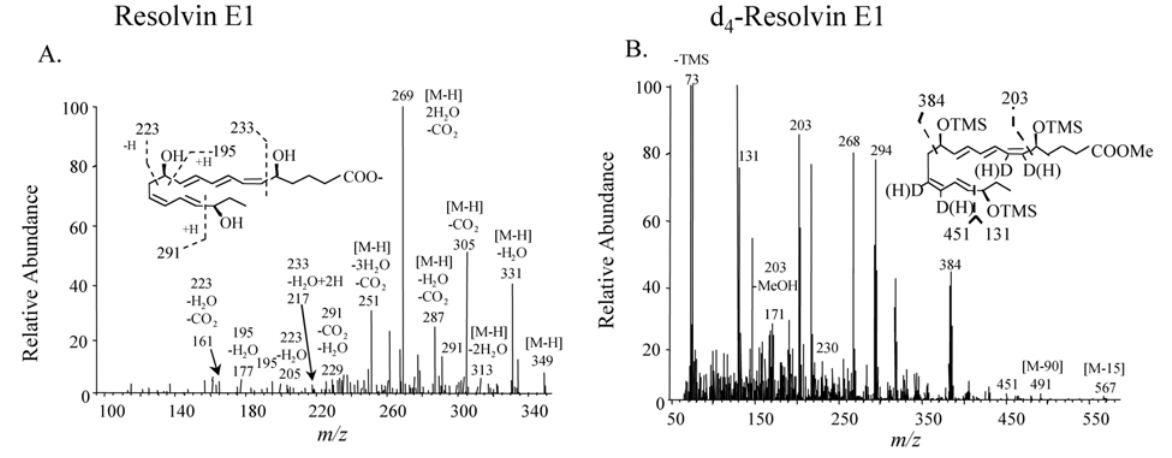
FIGURE 6. MS/MS spectrum of synthetic RvE1 and GC-MS spectrum of deuterated-RvE1. (A) MS/MS spectrum of synthetic RvE1. (B) GC- MS spectrum of the deuterated-RvE1 with methylation and